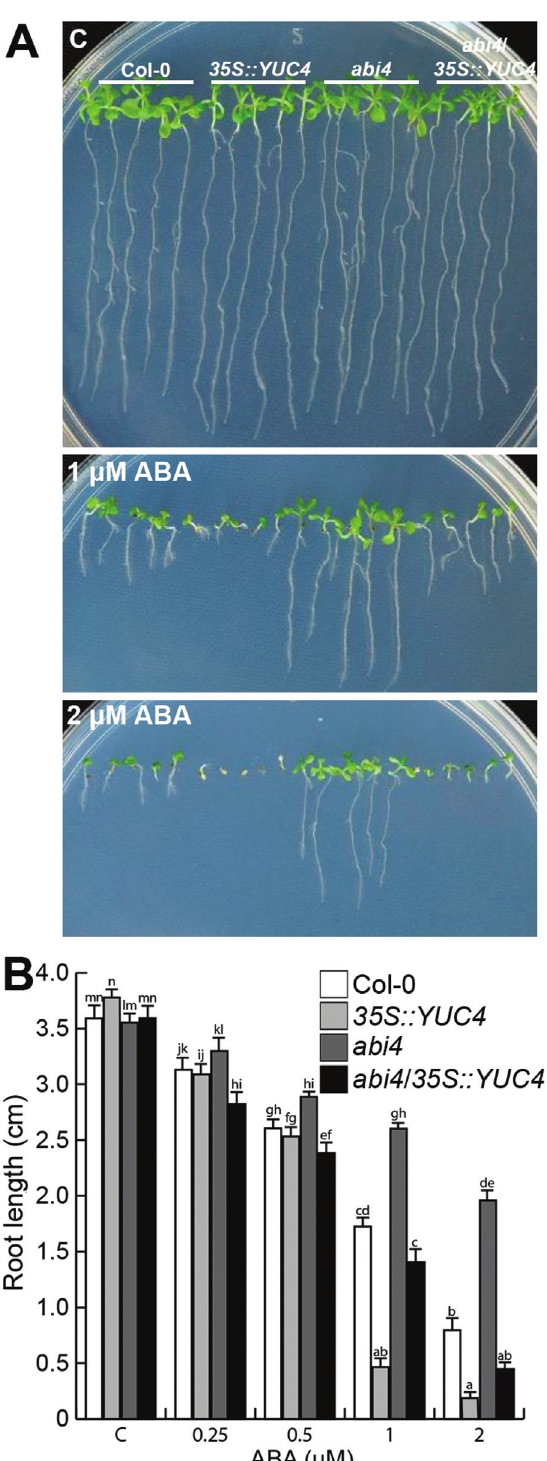
Figure 8 - ABI4 loss of function reduces 35S::YUC4 root hypersensitivity to ABA. (A) Representative images of plates with Arabidopsis lines Col-0, 35S::YUC4 , abi4 and abi4 / 35S::YUC4 sown on MS media supple- mented with the solvent or indicated ABA concentrations. (B) Root length of6dagWT, 35S::YUC4 , abi4 and abi4 / 35S::YUC4 at0,0.25.0.5,1and2 (cid:2) M ABA. Error bars represent standard errors from 15 seedlings analyzed andlettersindicatemeansthatarestatisticallydifferent( P <0.05).Theex- periment was repeated three times with similar